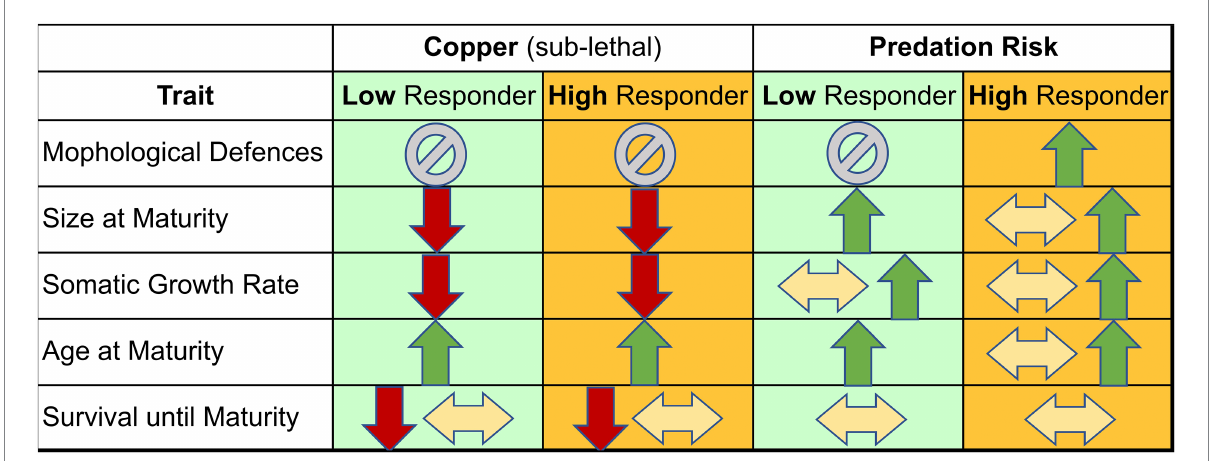
FIGURE 1 Candidate predictions for plastic responses to copper and predation risk by two classes of D. pulex genotypes: class one has a strong life history response, but a weak morphological response to predation risk (“low responder”) while class two is the opposite (“high responder”). As discussed in the text, copper is expected to reduce size, increase age and decrease growth rate due to reduced energy intake arising from disrupted digestive functioning (acquisition and assimilation). In contrast, predation risk is expected to increase size and decrease age at maturity and increase growth rate. This reveals the potential for some synergistic (age) and some antagonistic (size, growth rate) effects of multiple